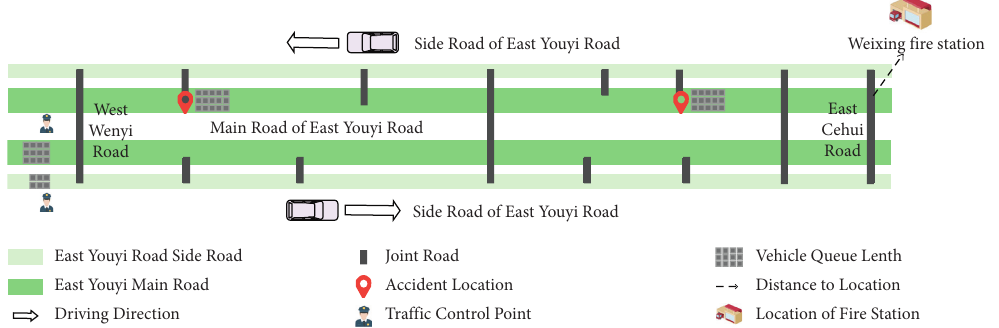
Figure 2: Location of East Youyi Road and surrounding schemes: scheme 1—reverse main road and side road control (RMSC), scheme 2—reverse main road control (RMC), scheme 3—prograde main road control (PMC), and scheme 4—prograde main road and side road control (PMSC),